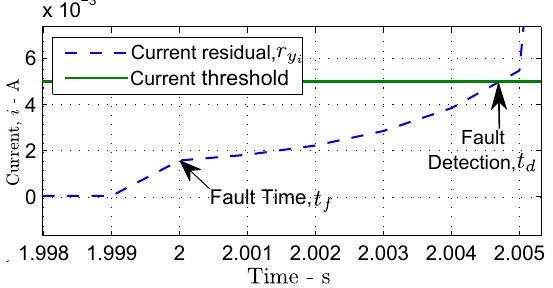
Figure 8. Current sensor residual, r y